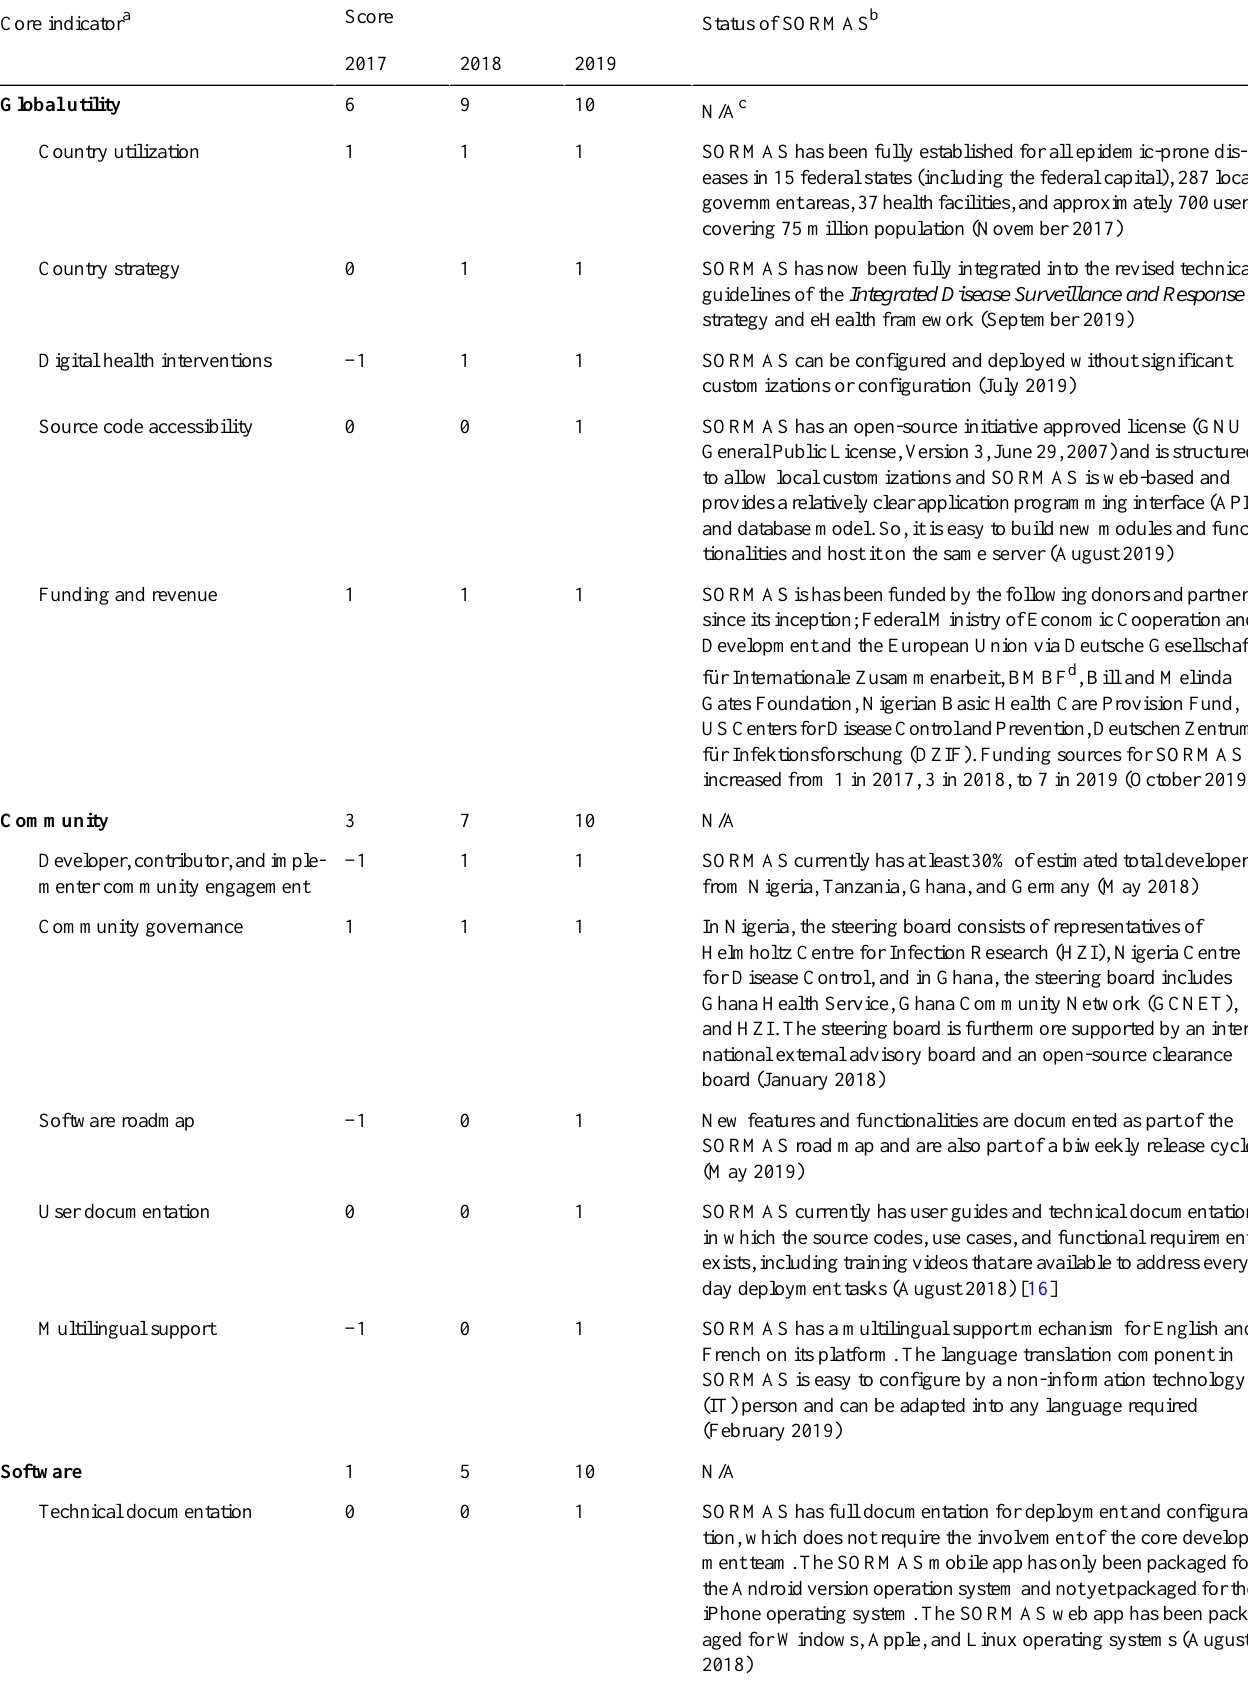
Table 2. The distribution of subindicator mean scores among the 3 core indicators (global utility, community support, and software maturity) for Surveillance Outbreak Response Management and Analysis System development from November 2017 to October